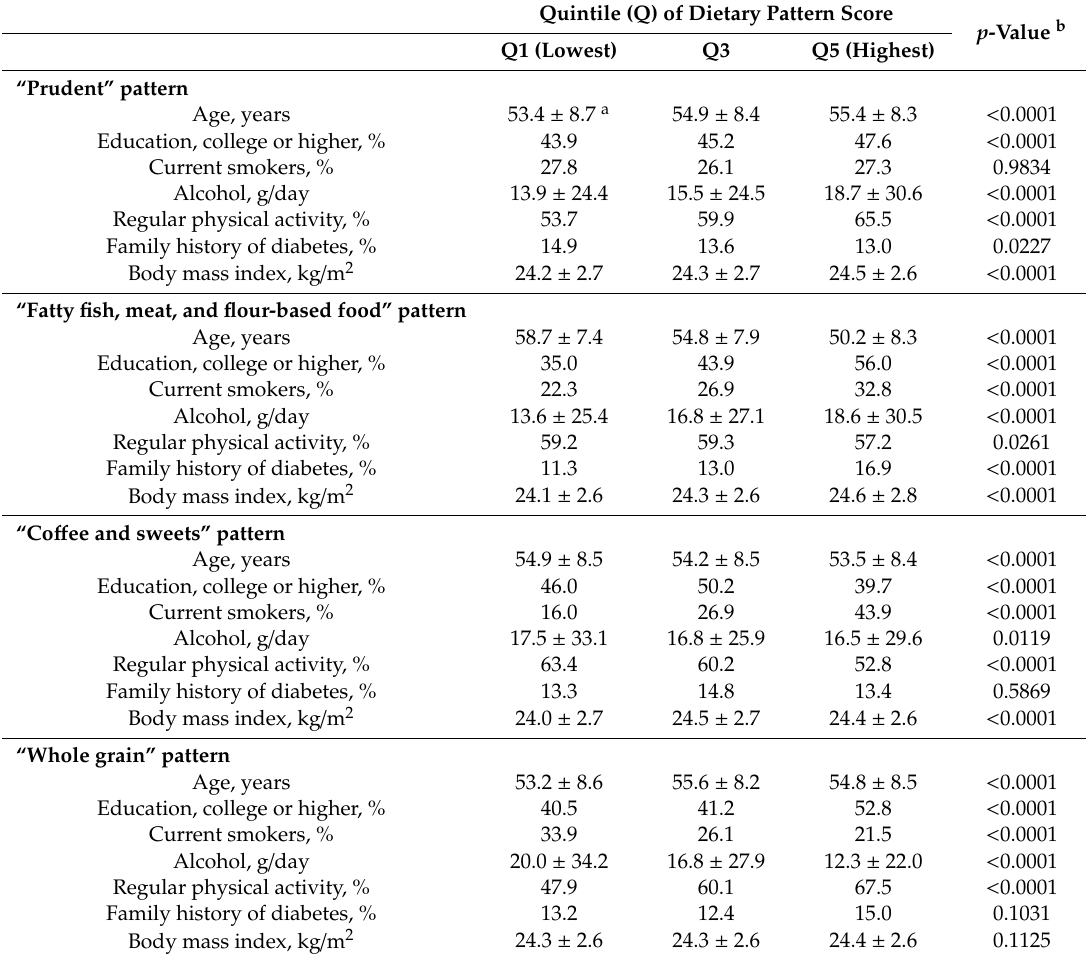
Table 2. General characteristics at baseline across quintiles of each dietary pattern score in the middle-aged Korean men, the KoGES-HEXA